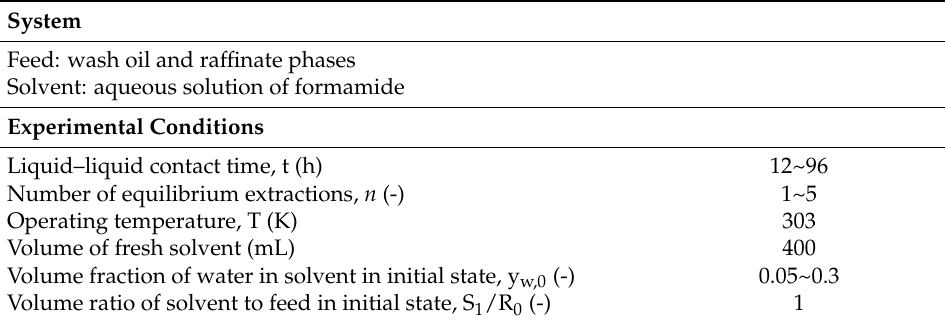
Figure 1. Schematic diagram for extraction method [2]. R: raffinate phase, E: extract phase, i: component i, 1, 2, 3, 4, 5: number of equilibrium extraction. Table 1. Material systems and experimental conditions.